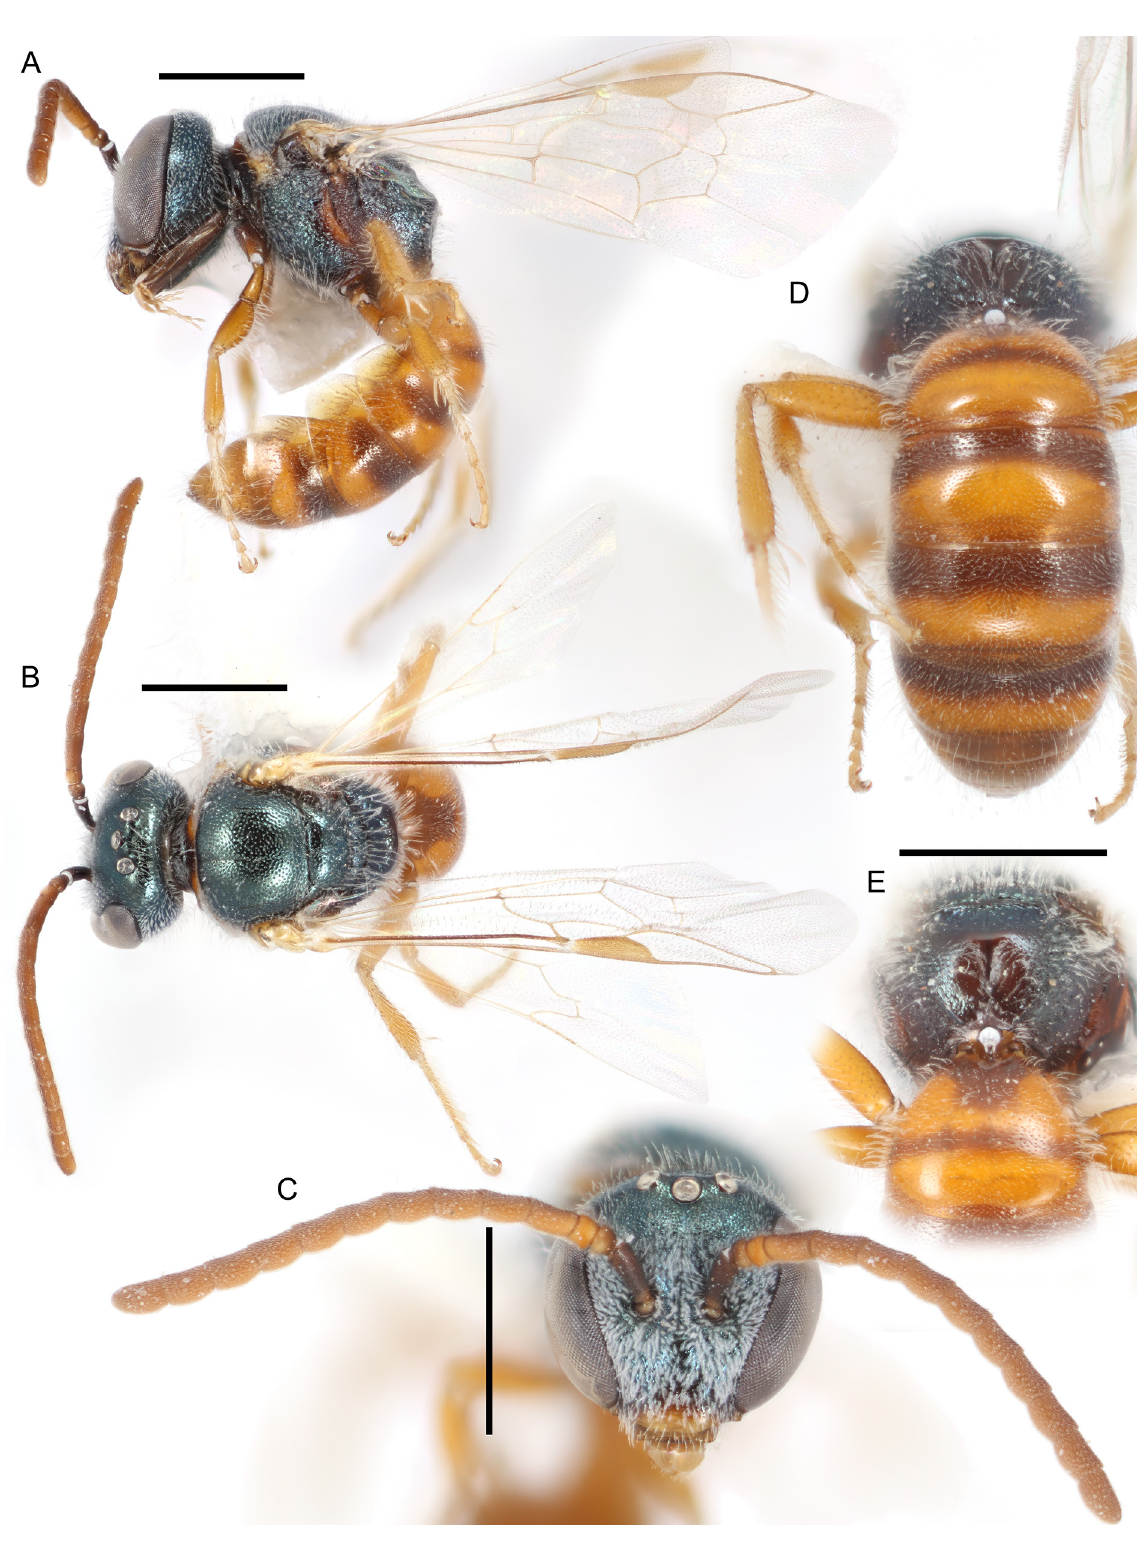
Fig. 39. Lasioglossum ( D. ) festinum sp. nov., ♂. A . Lateral habitus. B . Dorsal habitus. C . Face. D . Metasoma. E . Propodeum. Scale bars: 1